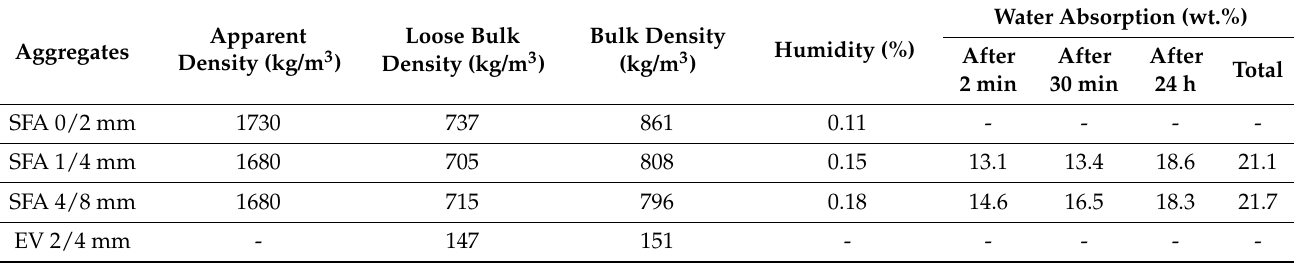
Table 1. Properties of SFA and EV